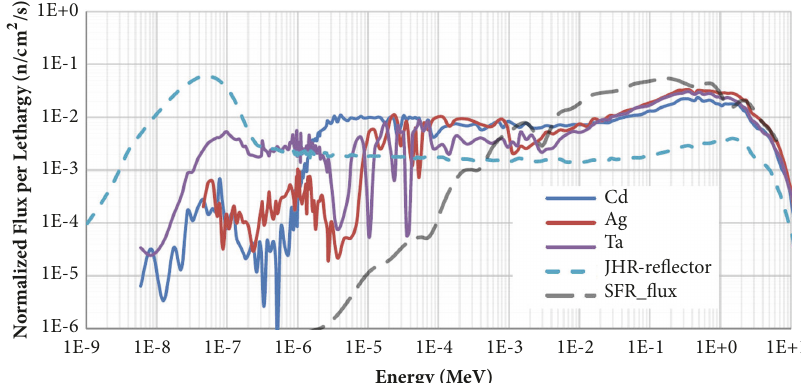
Figure 14: Effect of 3.4 cm Cd, Ag, and Ta neutron screens on the neutron spectrum. The neutron spectrum shifting and broadening are not sufficient. JHR reflector and SFR spectra are included for comparison.